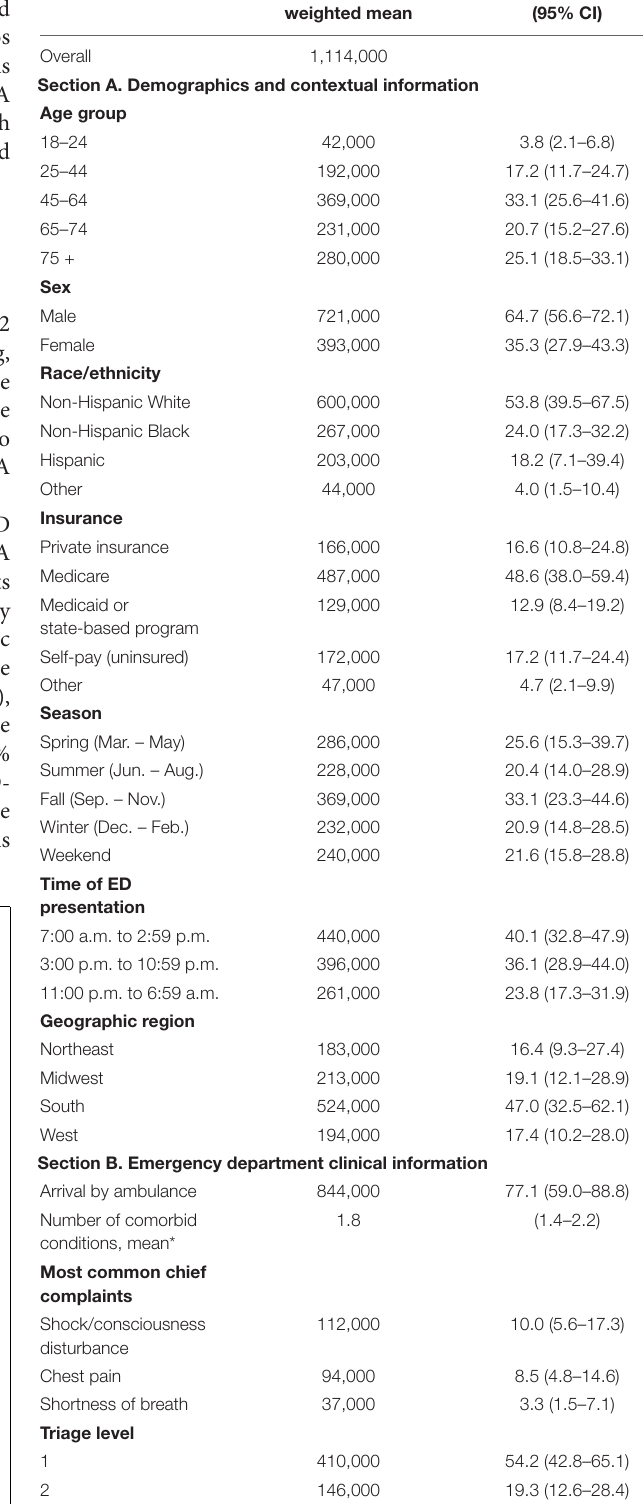
FIGURE 1 | The patient selection process.